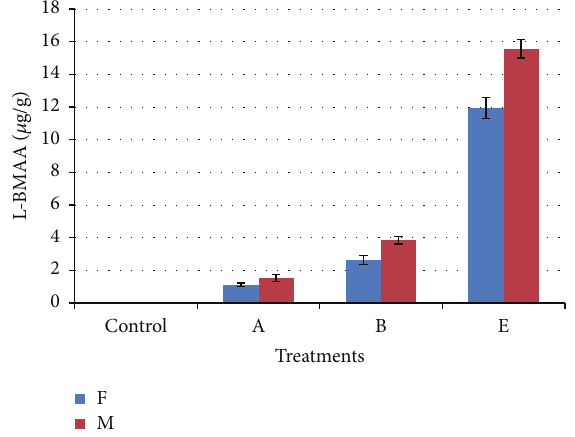
Figure7:ComparisonofL-BMAAconcentrations( 𝜇 g/g)inliversof maleandfemalemiceasdetectedbyLC/MS/MSchromatography.T- bars represent the mean of 𝑛 (𝑛 = 3 ) ± SD. A, B, and E: mice treated (0.03, 0.3, and 3 mg/g BW)